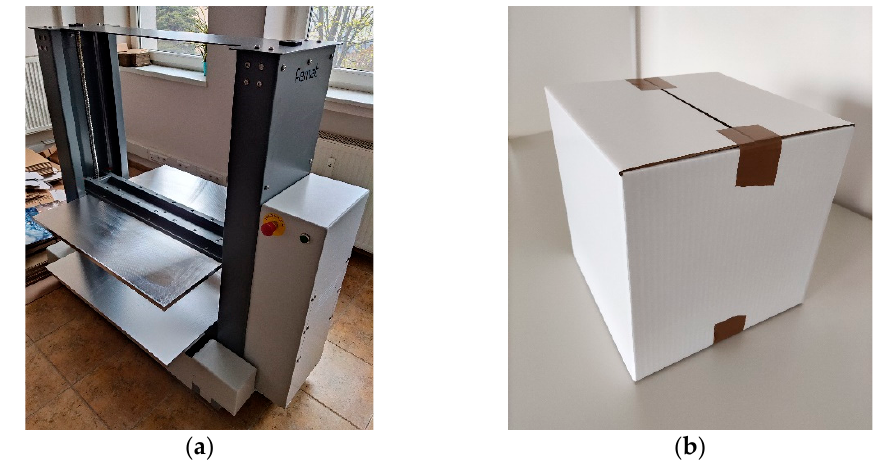
Figure 5. Box compression test: ( a ) the testing machine and ( b ) the box sample.